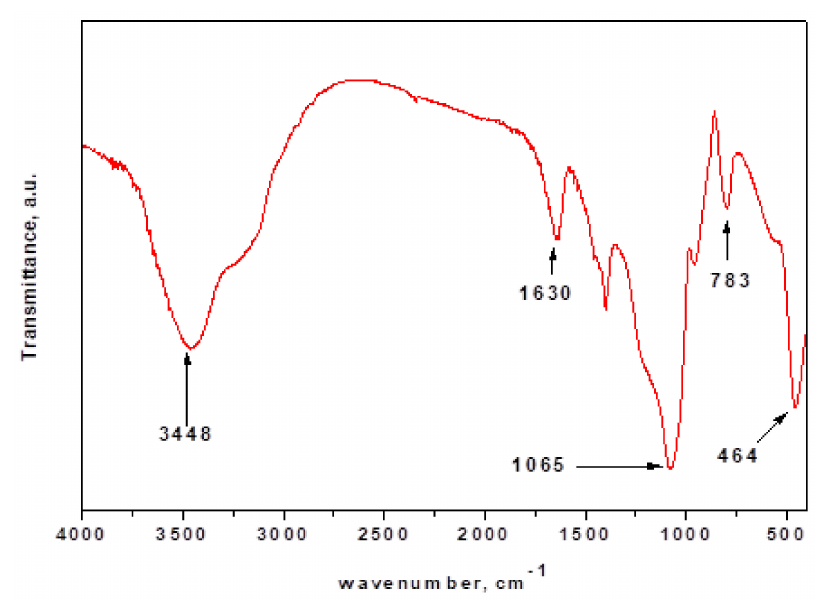
Figure 3. FTIR spectra of the silica